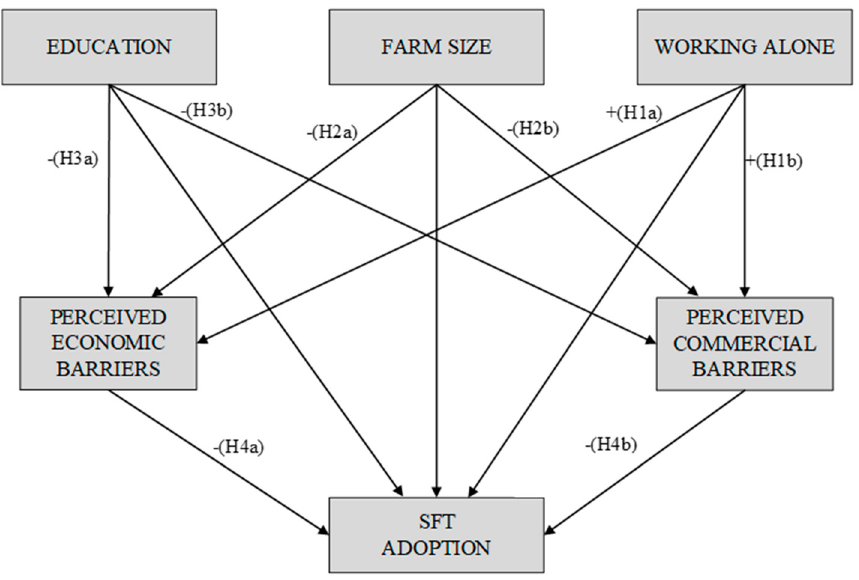
Figure 1. Expected relations among the model’s variables.